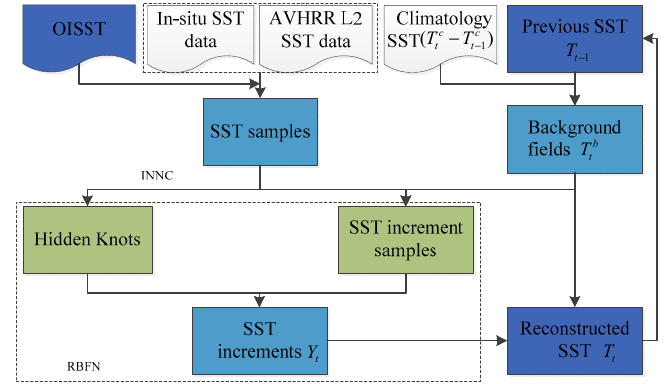
Figure 2. Schematic diagram of the RBFN method for reconstructing SST.